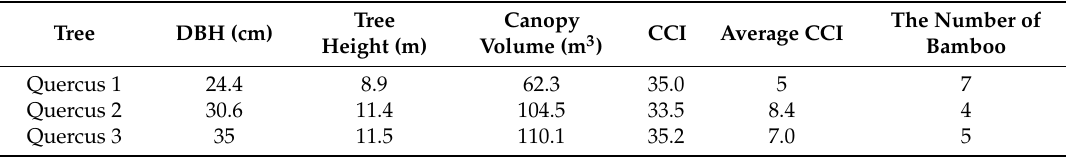
Table 8. Crown competition index (CCI) in a mixed forest of bamboo and broad-leaved